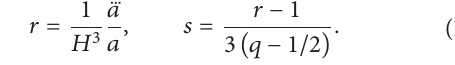
the Hubble parameter with time −1 unit. The combination of these two types of interactions also was considered.